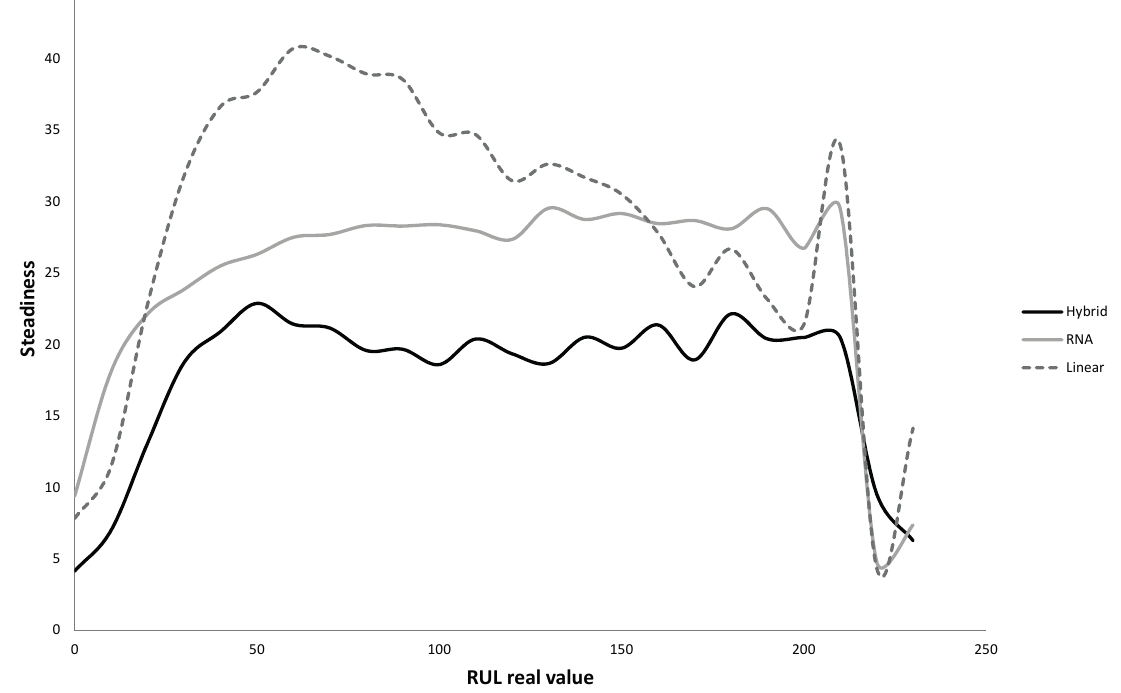
Figure 5. Steadiness of the hybrid model compared with the two benchmark techniques.